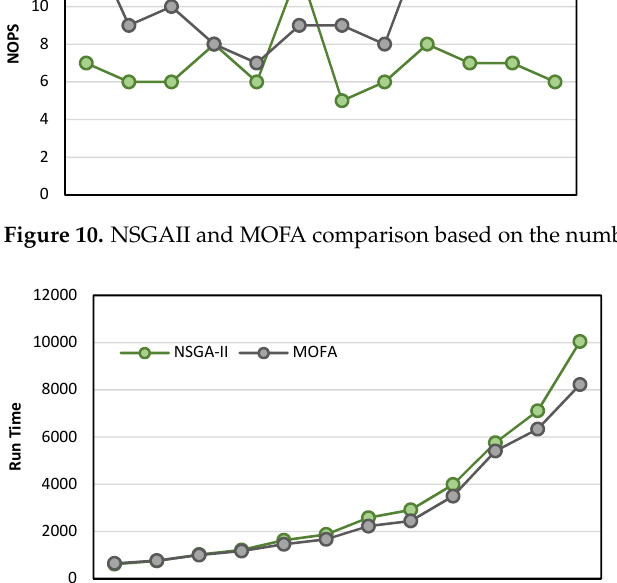
Table 8. Sensitivity analysis of the changes in vehicle capacity and demand functions simultane- ously. Capacity